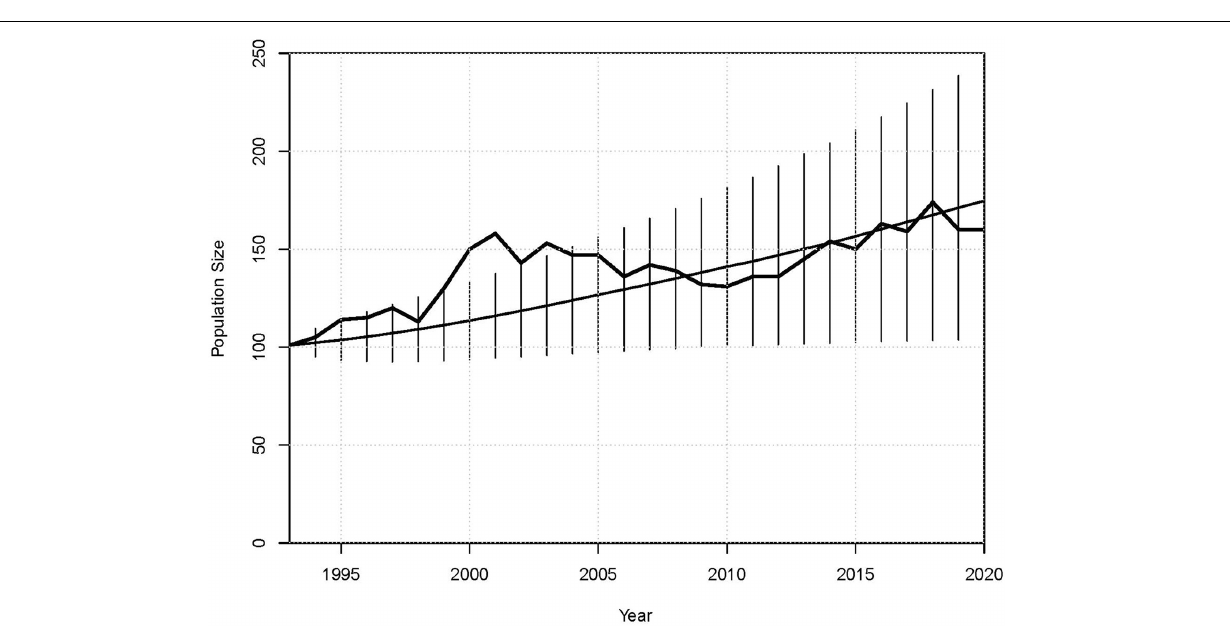
uncertainty of the final population size projected in 2020 (mean N = 175, SD =